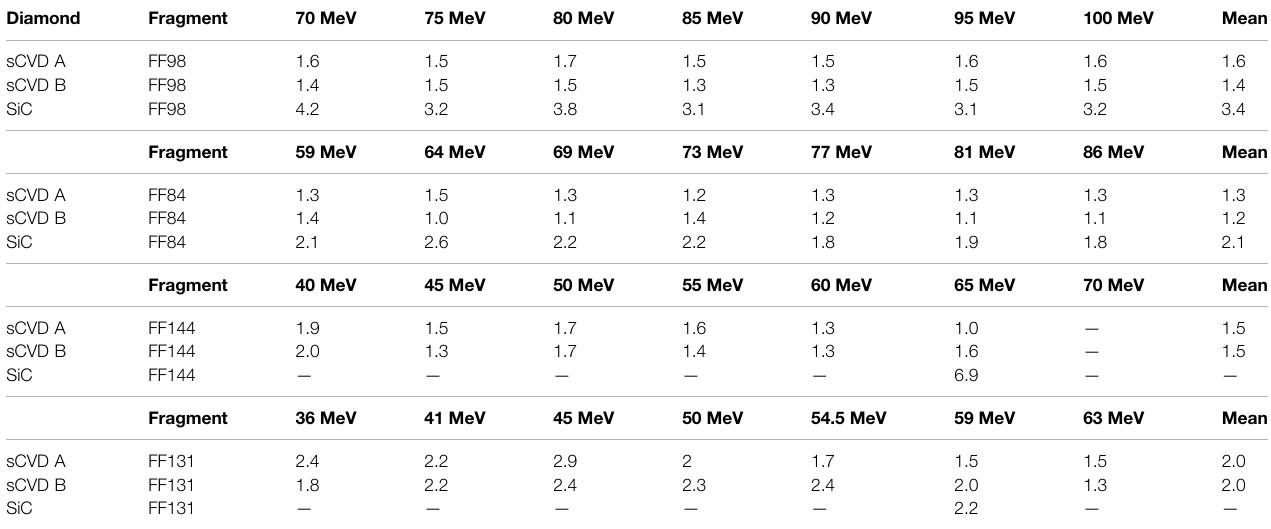
TABLE 3 | Summary of the energy resolution (RMS values in %) measured with various detectors on FF98, FF84, FF144 and FF131 at various energies. Bias voltage for diamond detector A is − 450 V; diamond detector B is − 200 V; and SiC detector is − 100 V.